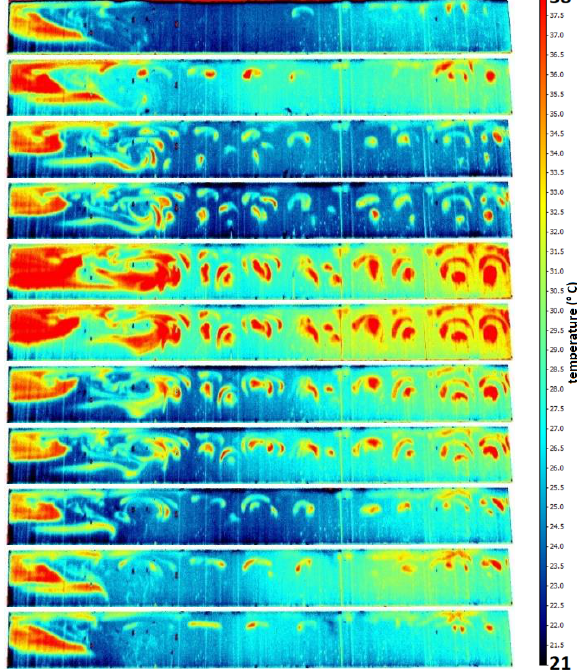
Fig. 3. 11 temperature map images over time with a constant time step of 0.66 s.